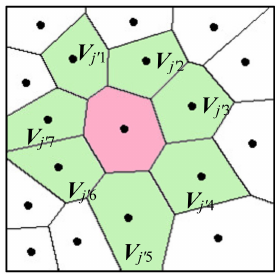
Figure 3. Neighbor system visual